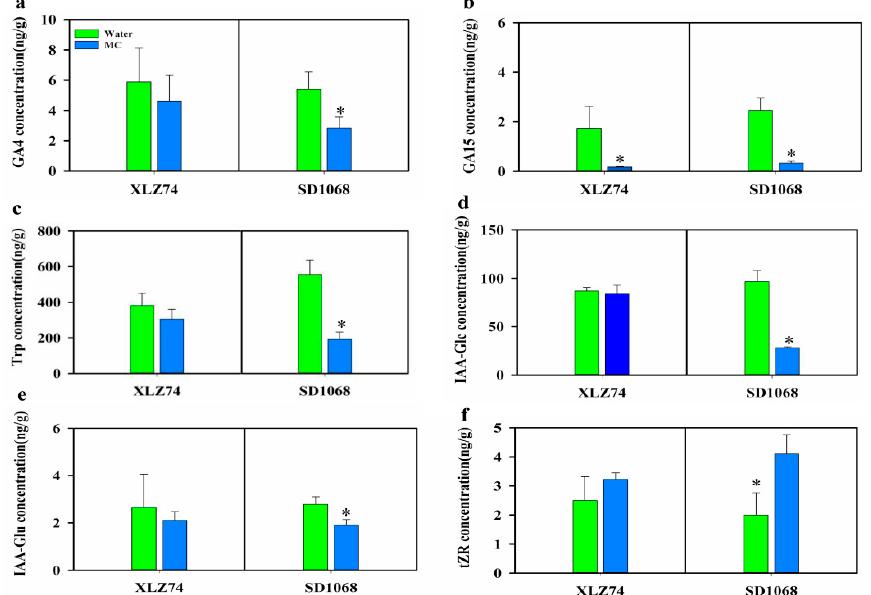
Figure 8. The contents of endogenous hormone in young stem from XLZ74 and SD1068 at 6d after MC treatment. ( a , b ) the contents of GA 4 and GA 15 ; ( c – e ) the content of Trp, IAA-Glc and IAA-Glu; ( f ) the tZR content. Error bars represent the SD of three biological replicates. * p < 0.05, Student’s t - test.